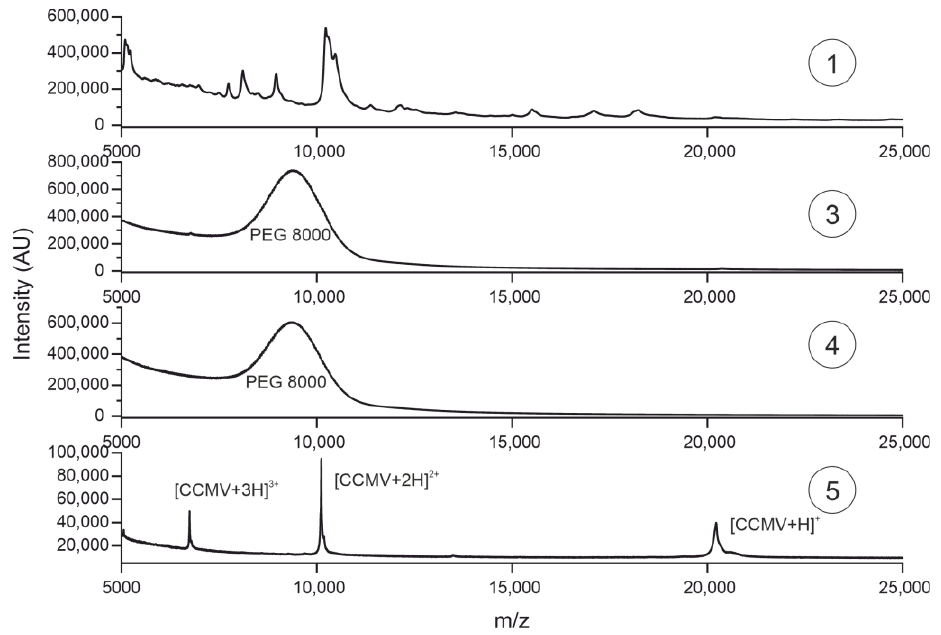
Figure 10. MALDI-TOF mass spectra of samples taken at different steps of the purification protocol are shown in Figure 7: 1 (cid:13) Crude extract; 3 (cid:13) filtered supernatant after pelleting with PEG 8000; 4 (cid:13) flowthrough of the affinity extraction; 5 (cid:13) eluate of the affinity